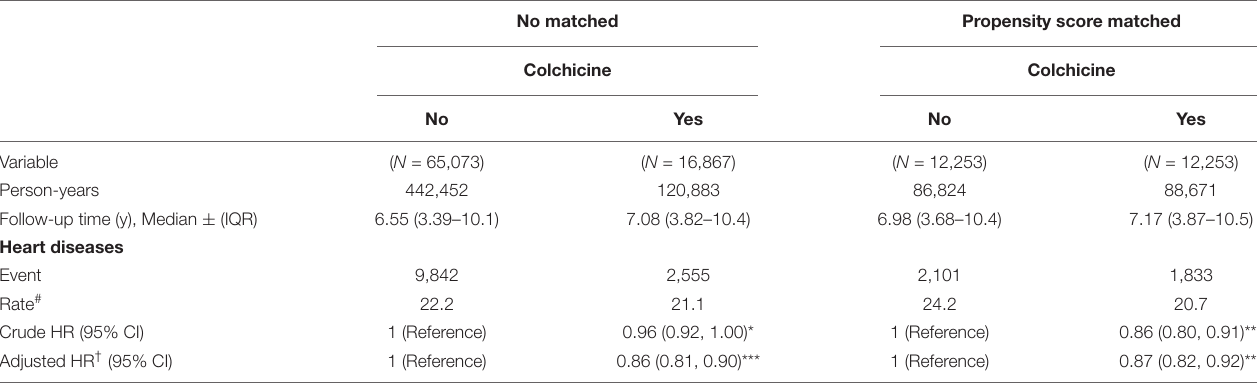
TABLE 3 | Incidence and HRs of HD in colchicine users compared with those in colchicine non-users by Cox proportional hazard models with time-dependent exposure covariates. No matched Propensity score